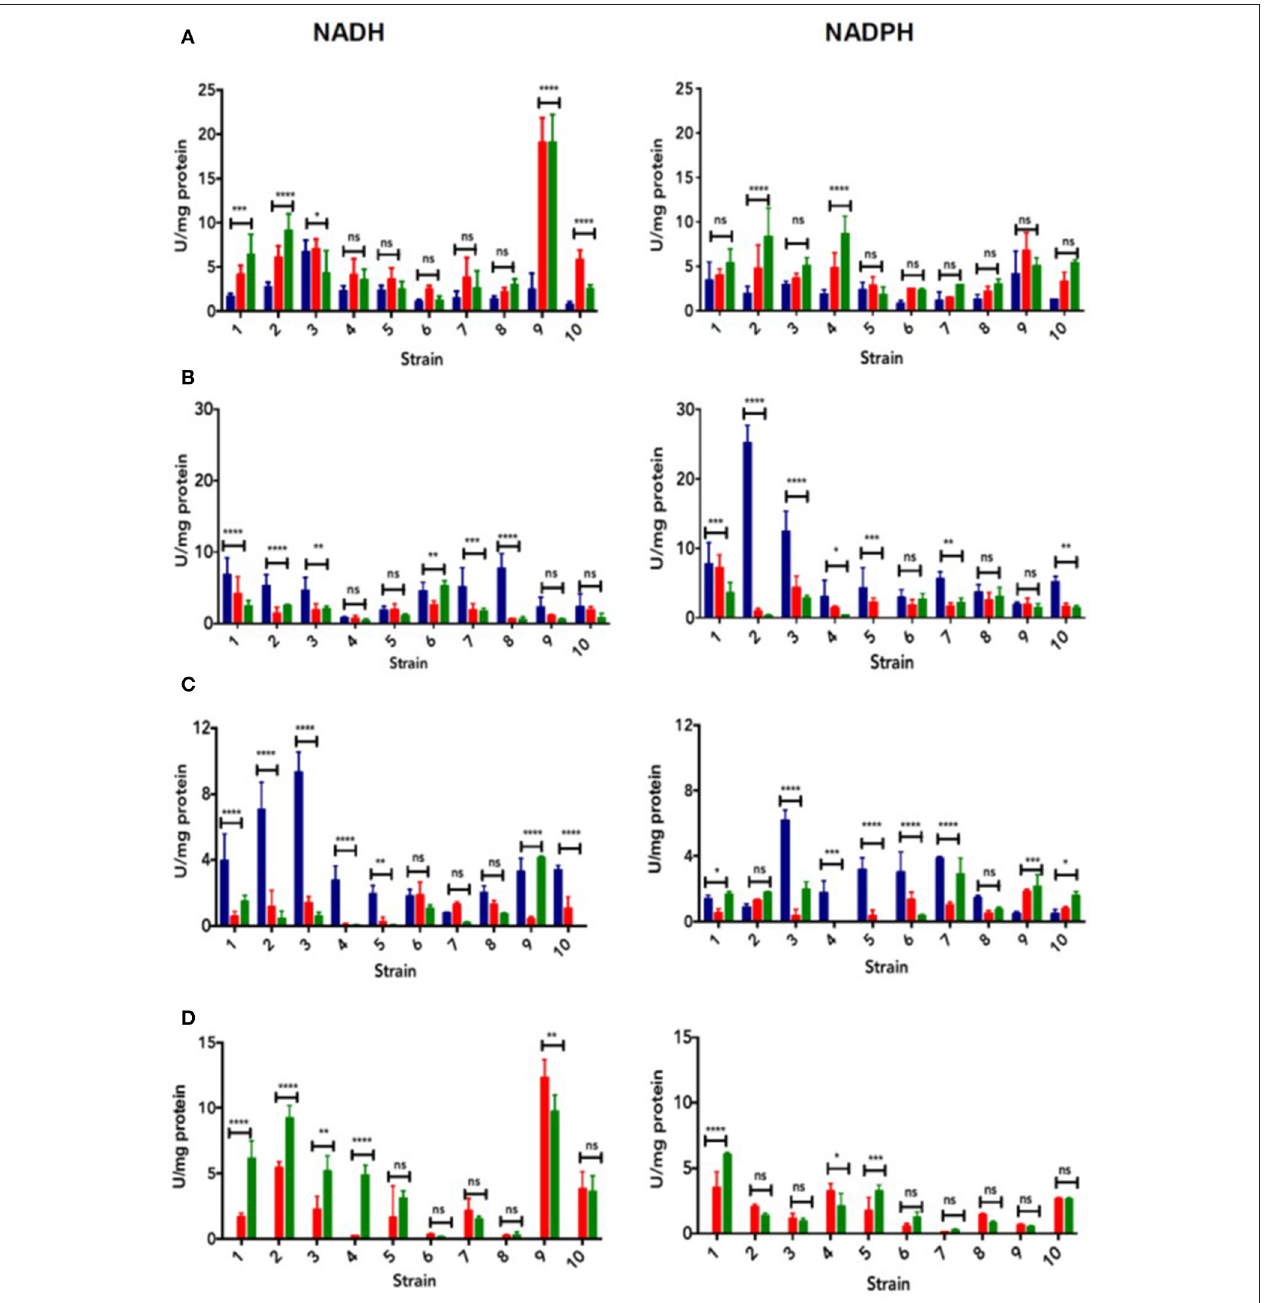
FIGURE 3 | Metal(loid)-reducing activity . Reduction of tellurium (IV) (A) , selenium (IV) (B) , silver (I) (C) , and gold (III) (D) , in the presence of NADH (left) or NADPH (right). Colored bars indicate different pH values tested: 7.0 (blue), 8.0 (red), and 9.0 (green). Horizontal bars indicate the statistical analysis within the group. Data represent the average of 3 independent assays ± SD. Statistical significance was according to section Data analysis.